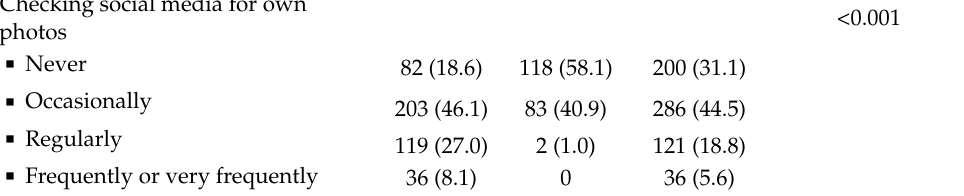
Table 1. The frequency and percentage distributions of basic characteristics among study participants from Malaysia ( n = 440) and Finland ( n = 203). Statistical significances between countries were evaluated by chi-square test.